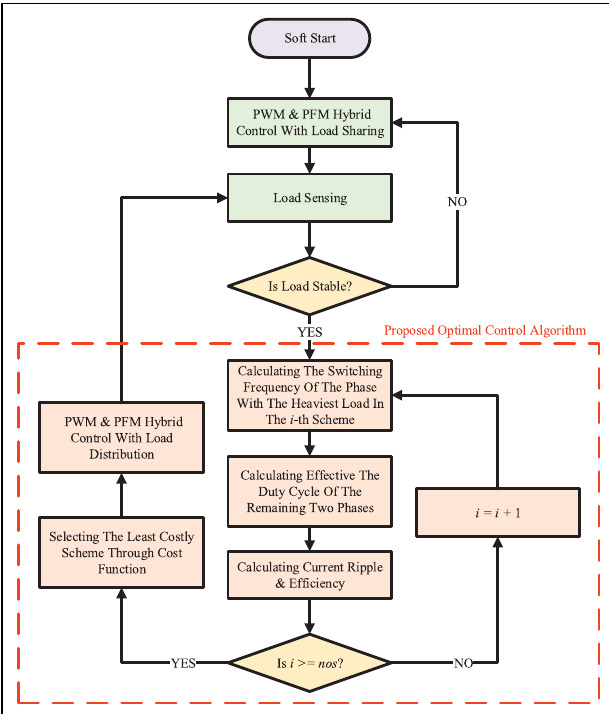
FIGURE 7 | The proposed current ripple and efficiency optimal control